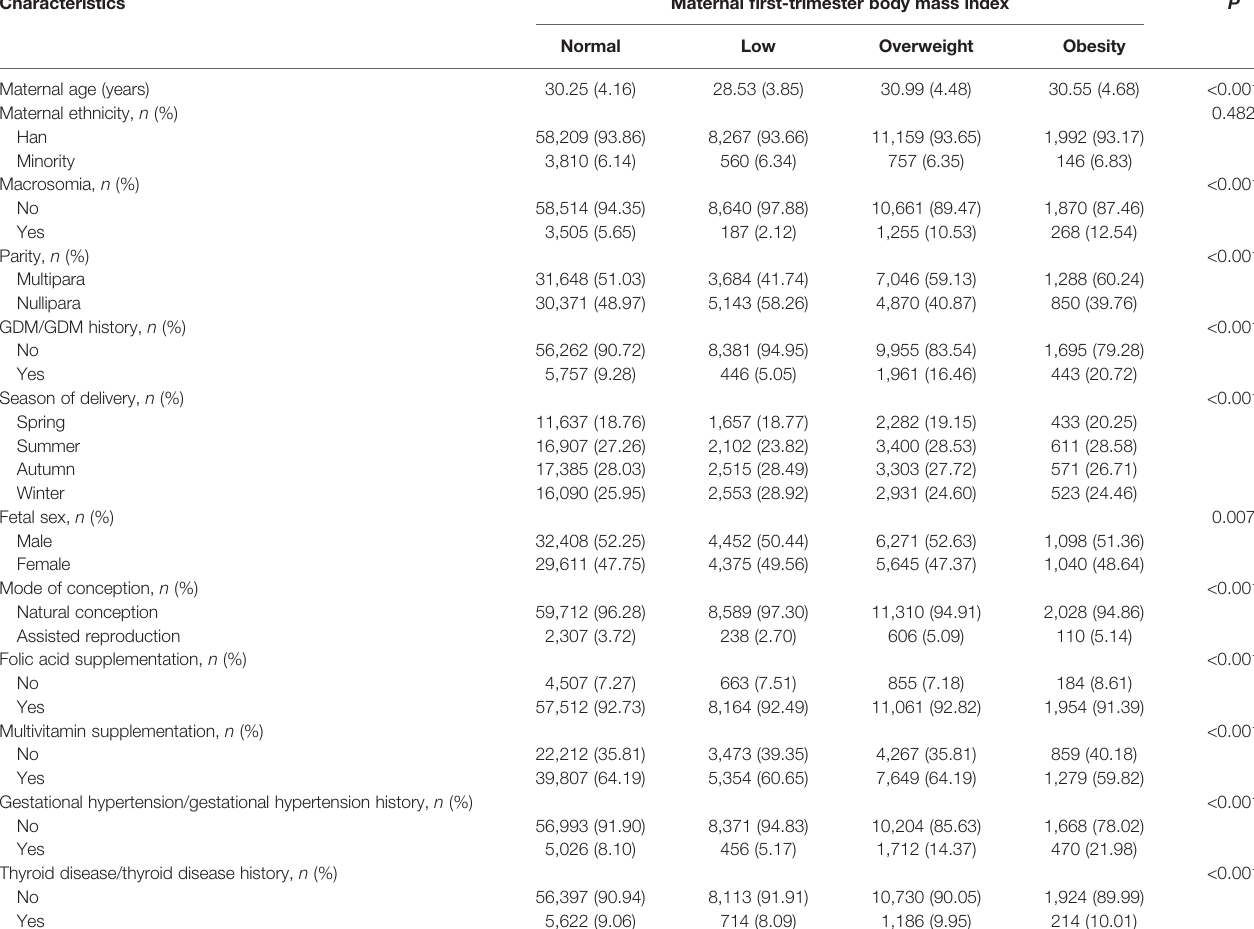
TABLE 1 | Characteristics of the participants.